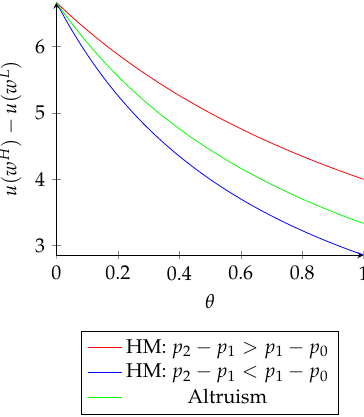
Figure 1: Comparing the power of optimal contracts